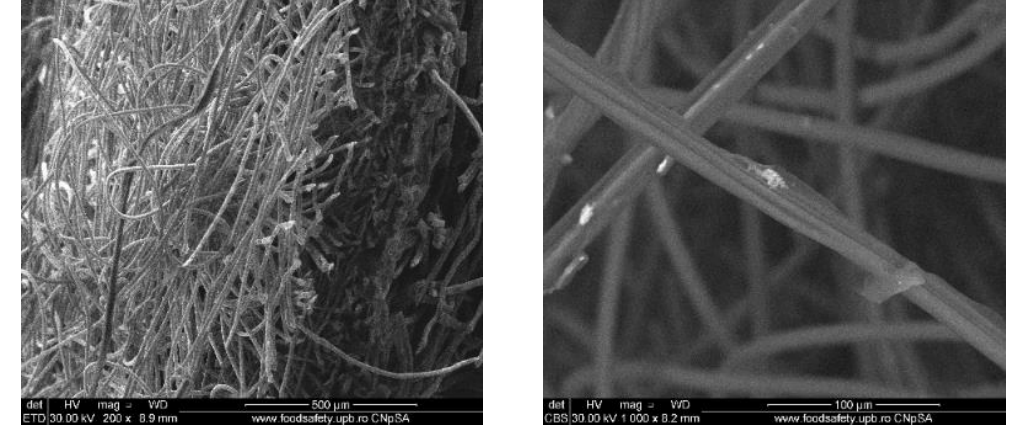
Figure 6. SEM images of wound dressings with silver nanoparticles, sodium alginate and niaouli oil. Left: global image, and right: detailed image.